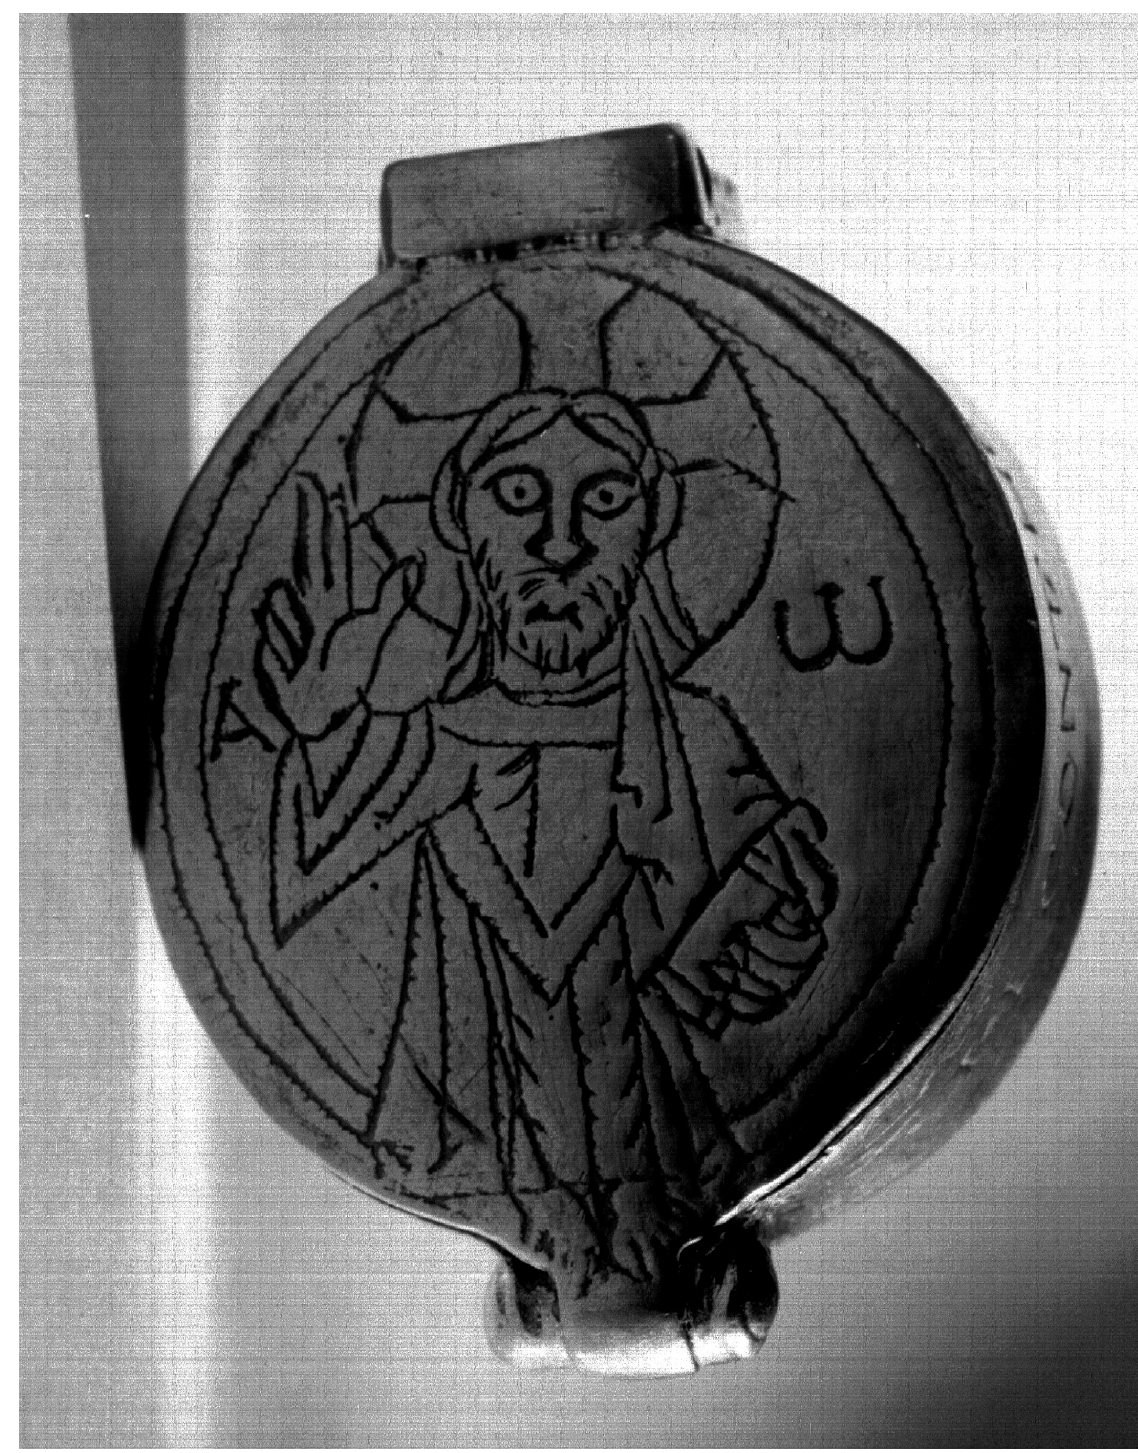
Figure 1. Outer reliquary capsule associated with the sainte Vertu, silver gilt and niello, late eleventh